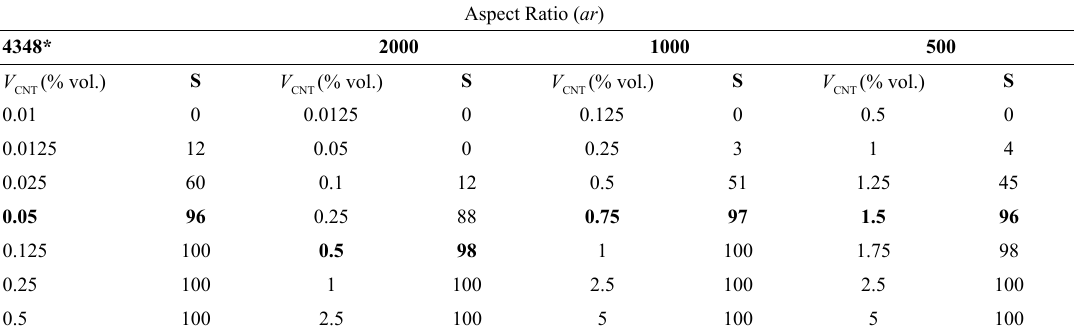
Table 3. Simulation of pc,CNT with ar variable of CNT and evaluation of percolation success in 100 consecutive simulated matrices.